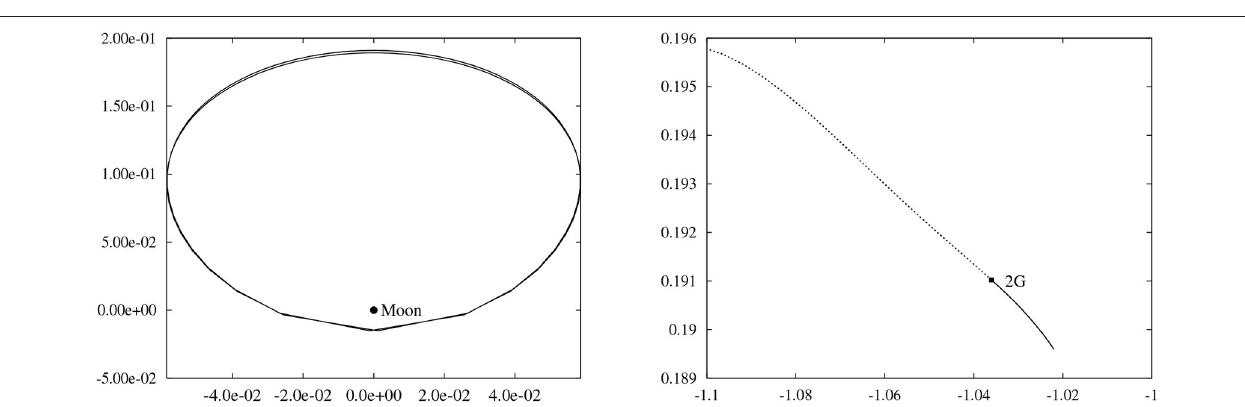
FIGURE 9 | Left: Resonant orbit 2 G . Right: Approximation of order 64 of the stable (dashed) unstable (solid) manifolds of the ressonant orbit 2 G . Horizontal axis y . Vertical z .